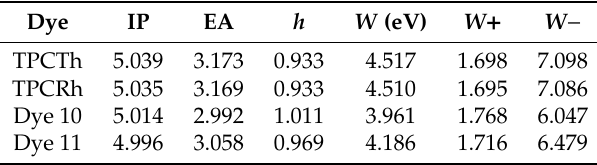
Table 7. Ionization potential (IP) (electron a ffi nity (EA)) and chemical parameters for four dyes. Dye IP EA h W (eV) W + W